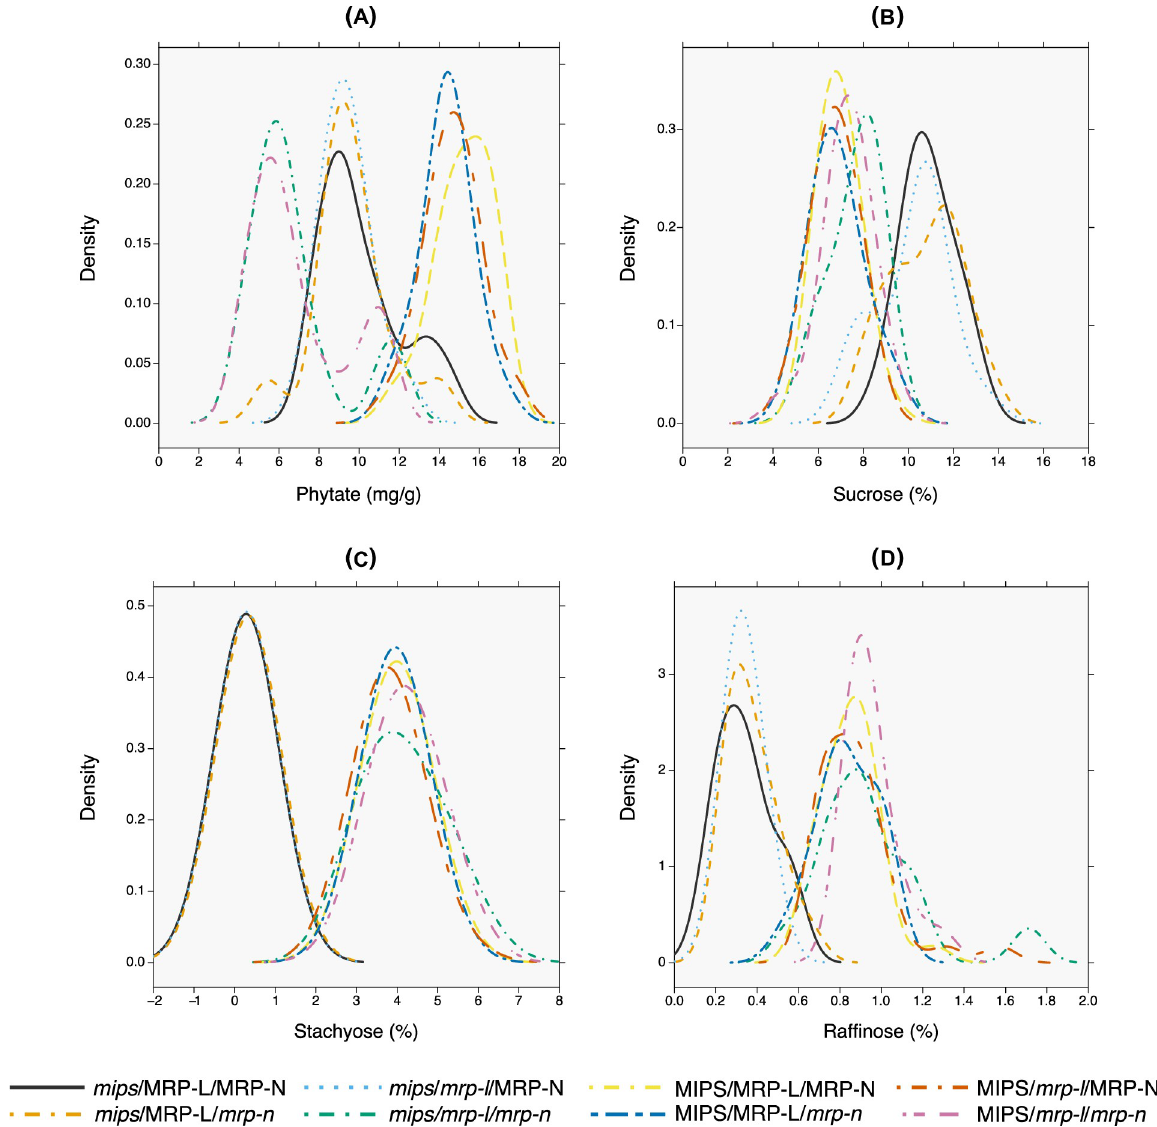
Fig 2. Distribution of seed phytate and oligosaccharide contents of recombinant inbred lines in the eight genotypic classes within the V99- 5089 x CX1834 RIL population. Gaussian kernel density estimation for each of these datasets is represented for each genotypic class at the bandwidth of 0.8 for (a) phytate, (b) sucrose, (c) stachyose, and 0.08 for (d) raffinose. The oligosaccharide (sucrose, raffinose, stachyose) contents are represented as percentage of dry seed weight.